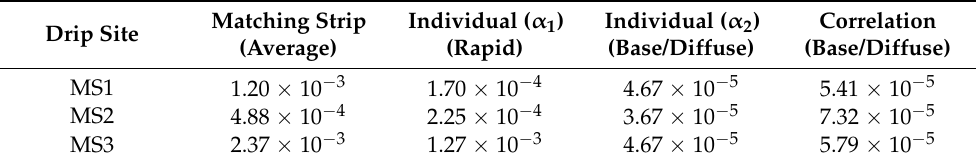
Table 5. Values of α (min − 1 ) for MS1, MS2, and MS3, using the matching strip method (average flow), the correlation method (base/diffuse flow) and the individual hydrograph separation method (rapid flow and base/diffuse